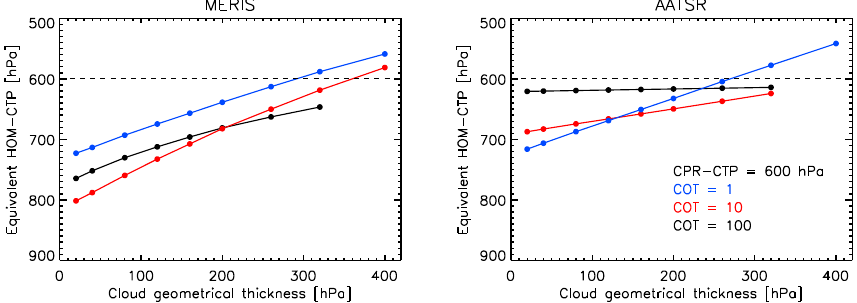
Figure 2. The equivalent HOM CTP for varying CGT and COT, assuming a CPR-cloud with CTP = 600hPa. Settings in the radiative transfer simulations: satellite viewing angle = 0 ◦ , solar viewing angle = 35 ◦ , relative azimuth angle = 0 ◦ , surface albedo = 0.02 and MERIS central wavelength = 762nm.